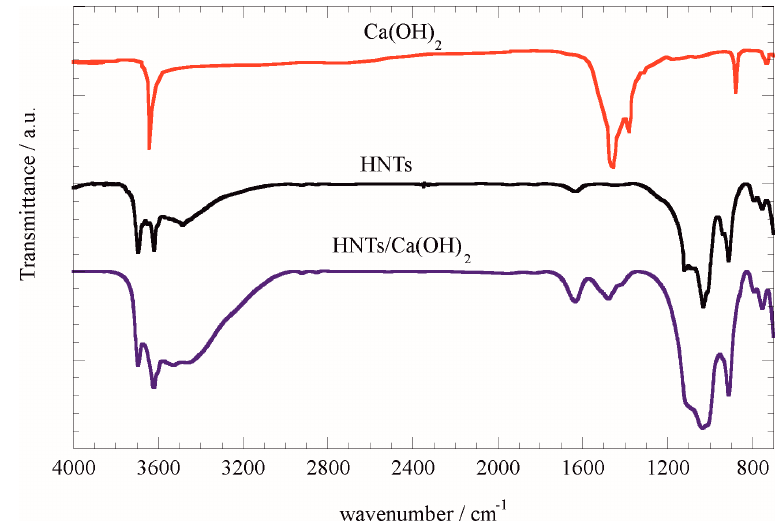
Figure 1. FTIR spectra for Ca(OH) 2 , HNTs and HNTs/Ca(OH) 2 .